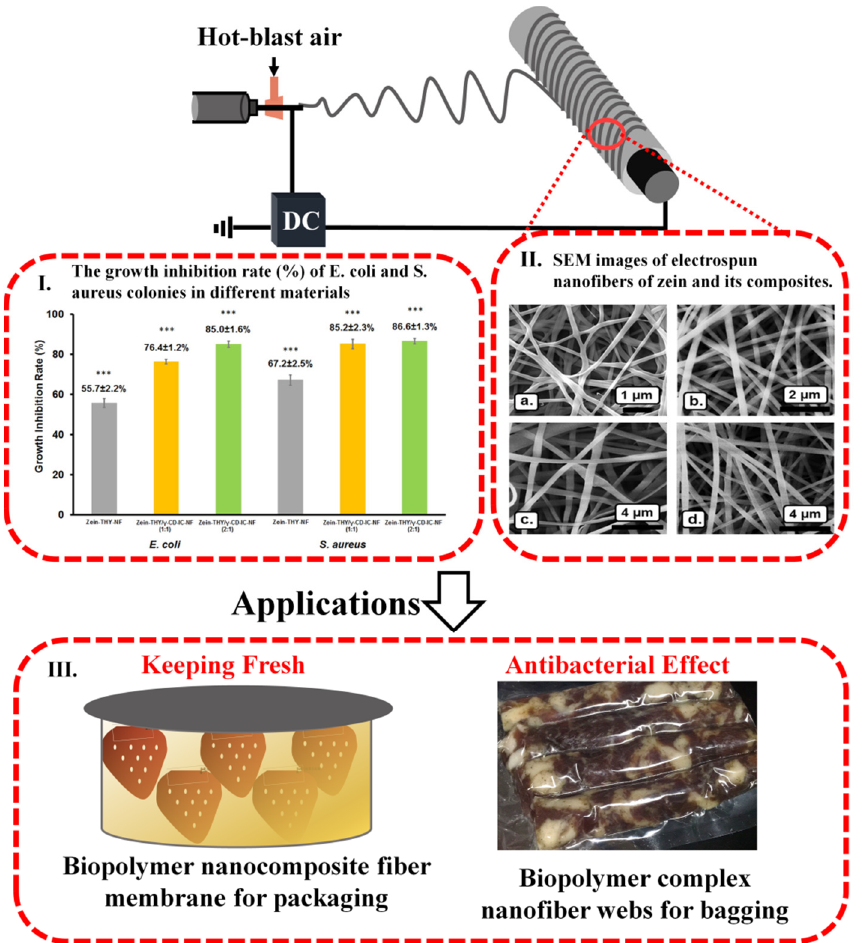
Figure 6. Biopolymer composite nanofibers obtained by electrospinning are used as ecofriendly packaging materials for fruits and meat, providing antibacterial properties and keeping food fresh [87]. Reproduced with permission from [87]; copyright (2017) Elsevier Ltd. Table 2. Applications of electrospinning technology in biology, environmental protection, ecofriendly energy, and packaging materials.